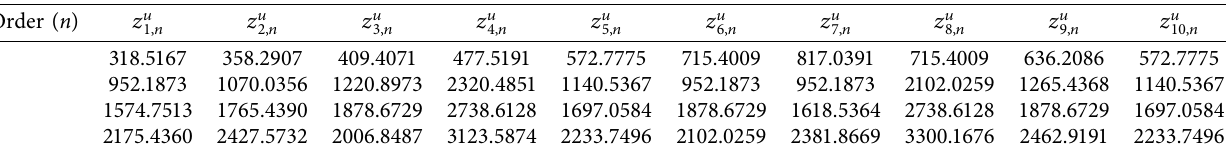
Table 3: The first four antiresonance frequencies of different driving points ( j � 1, 2, ... , 10) for undamaged 10-cell periodic rubber–steel structure.